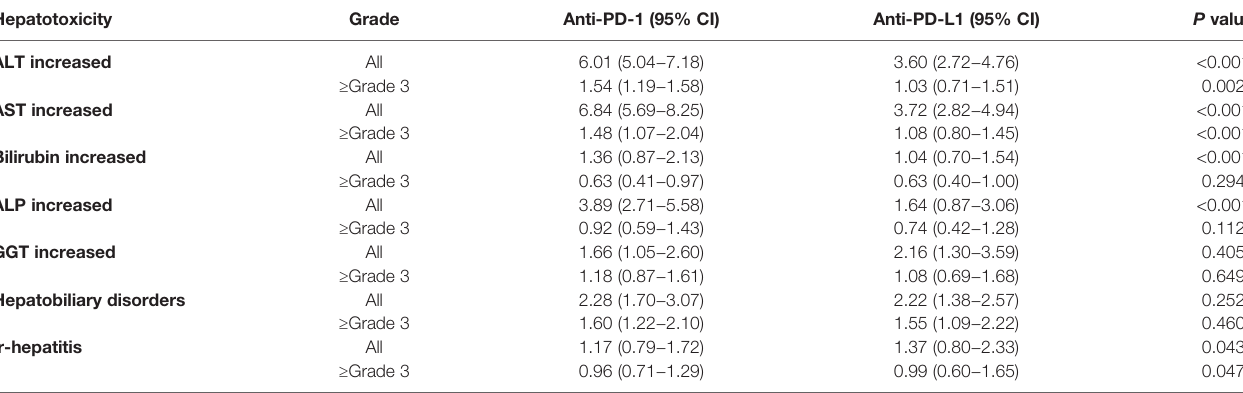
TABLE 2 | Incidence of hepatotoxicity secondary from anti-PD-1 vs. anti-PD-L1.